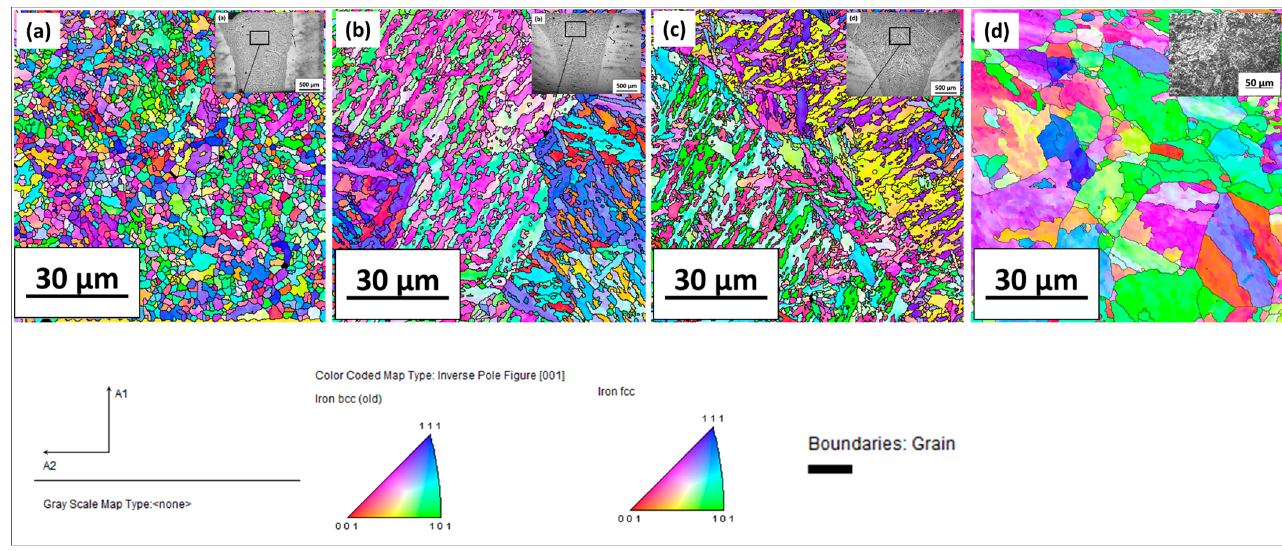
Figure 6. IPF maps with and without beam oscillation conditions for ( a ) S1000V60I35 OD2 mm, ( b ) S1000V60I35 OD 0.5 mm, ( c ) S1000V60I35 WO and ( d ) base metal.